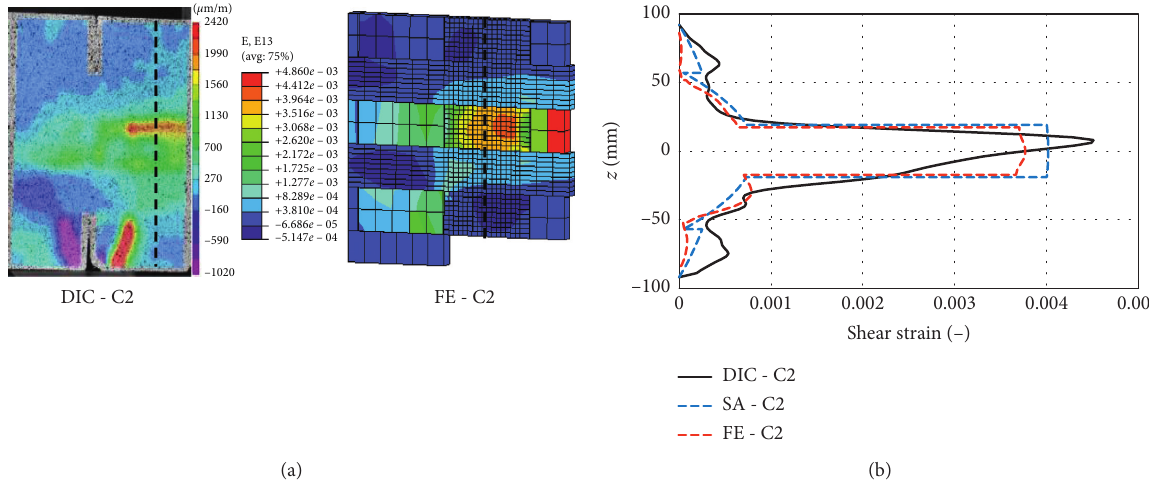
Figure 9: Colour contour plots and shear strain distribution from shear tests for C2.